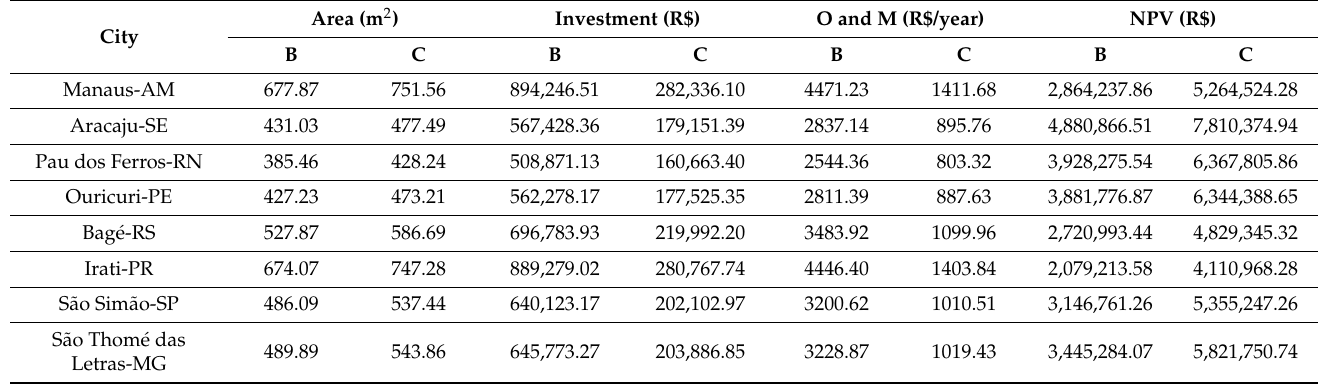
Table 7. Results of the deterministic simulations of NPV for the defined cities.